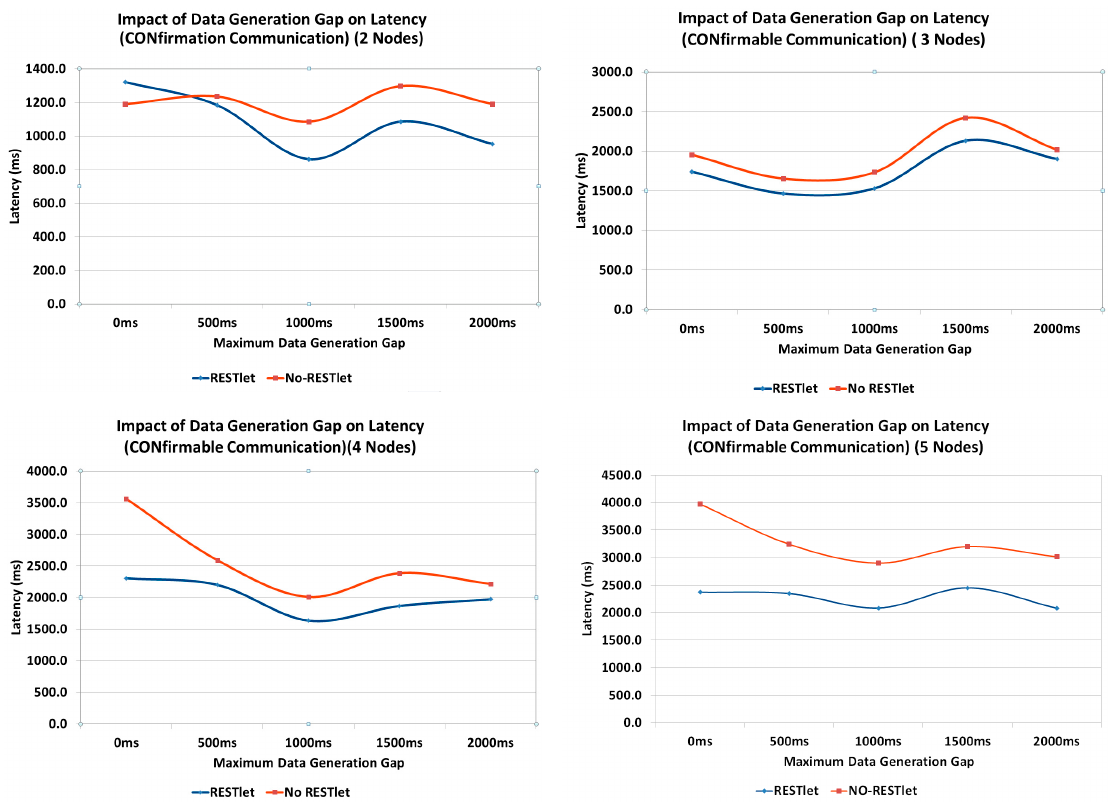
Figure 23. Impact of Packet Arrival Time Gap on Latency.